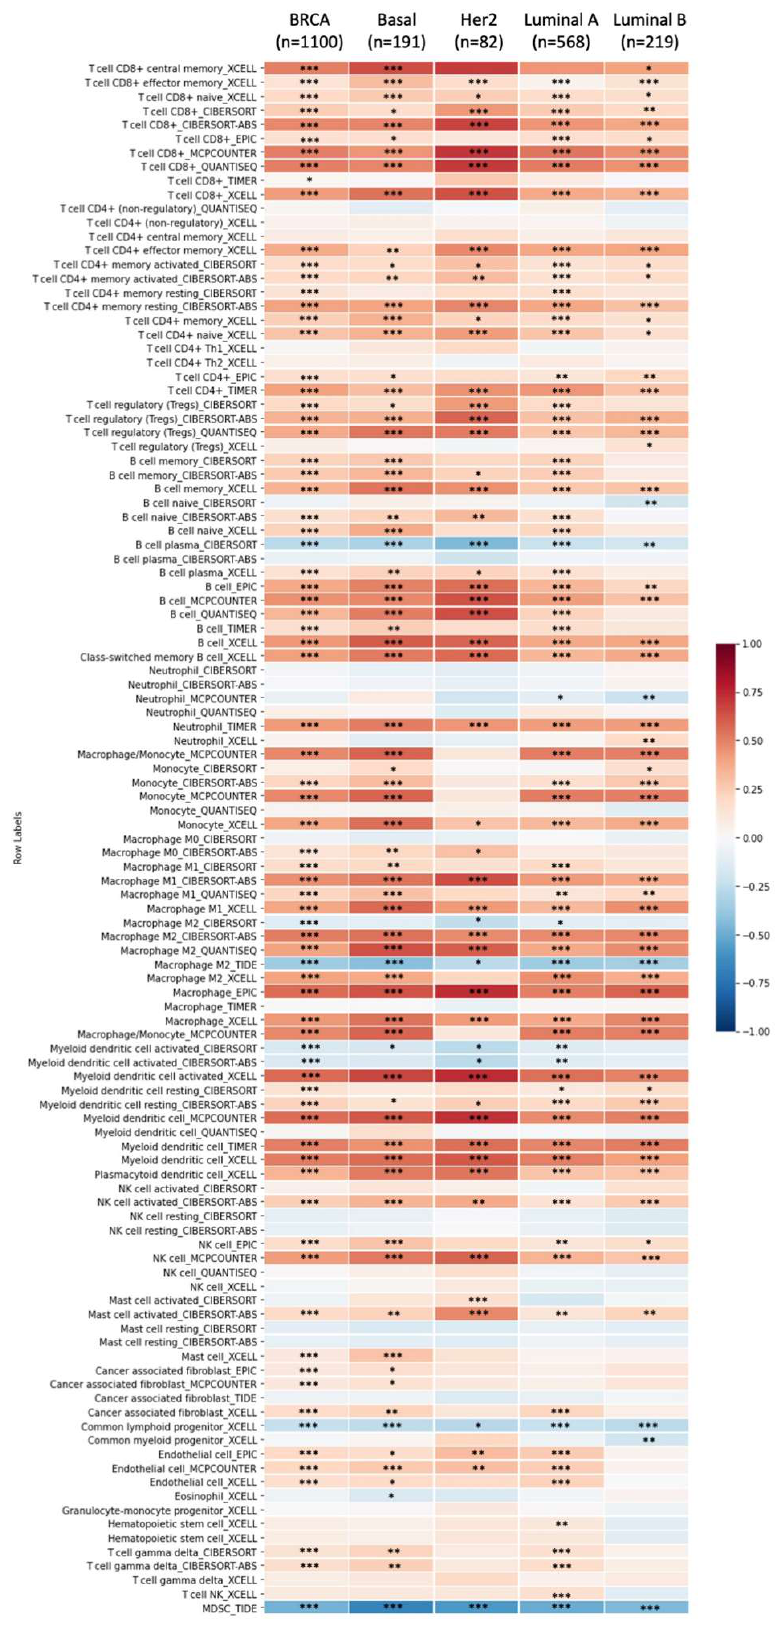
Figure 10. Relationship between GPSM3 expression and immune infiltration level in breast cancer (TIMER2). Correlation coefficients were calculated from seven cell type quantification algorithms